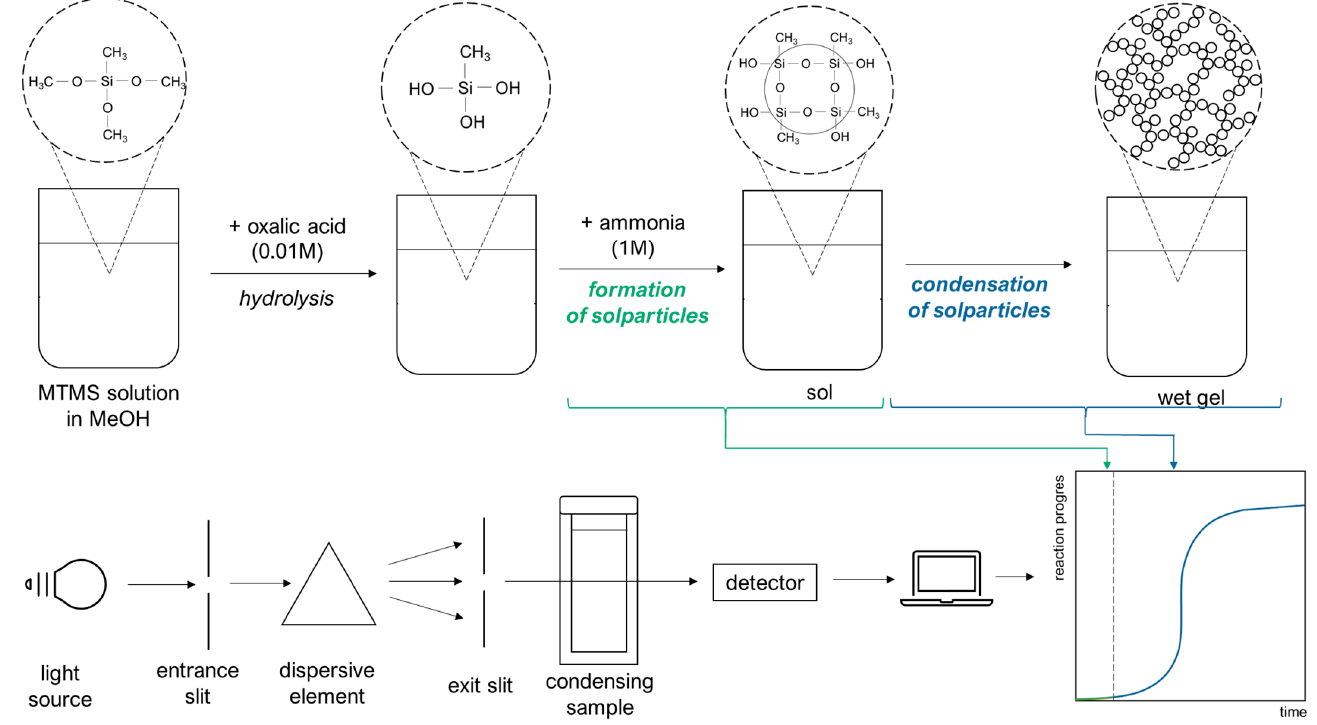
Figure 18. Scheme of MTMS alcogel synthesis with parallel spectrophotometric measurements of condensation kinetics.